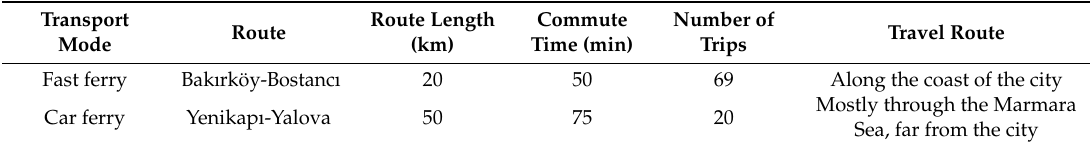
Figure 1. Routes for fast ferry and car ferry. Table 1. The route characteristics.